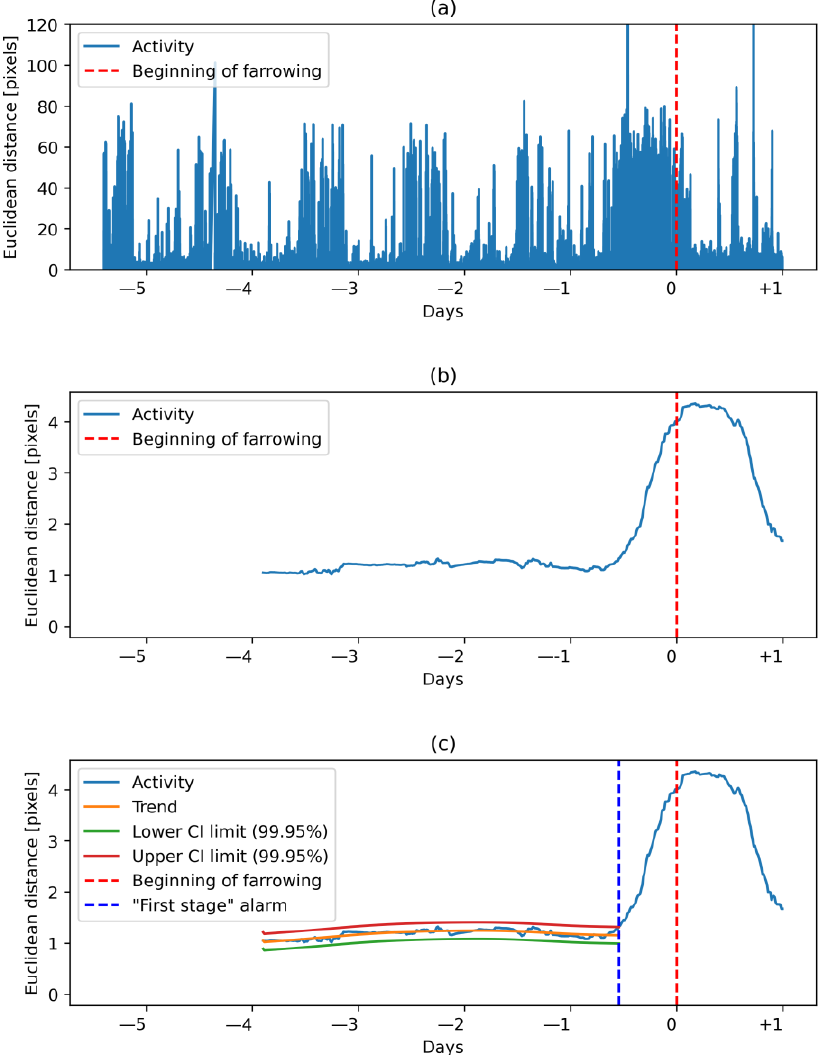
Figure 4. Euclidean distance calculated on centroids of detected sows. The period depicted in the plot starts at the introduction of a sow to a farrowing pen and ends around 1 day after the beginning of farrowing. ( a ) Euclidean distance calculated on consecutive frames. Peak activity was a few h before the onset of farrowing. ( b ) Mean of Euclidean distance calculated with a sliding window of 24 h and 15 min steps. The first 12 h of input variable was removed. Variation in activity related to diurnal rhythms was smoothed out. ( c ) Activity trend estimated on an expanding window of Euclidean distance. The “first-stage” alarm was at 13 h, before the beginning of